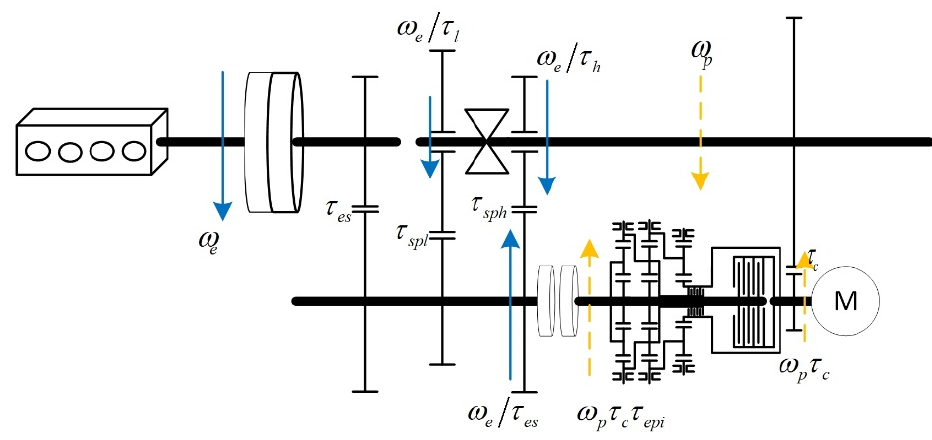
Figure 2. Kinematic diagram of AMT with gearshift assistant mechanism.